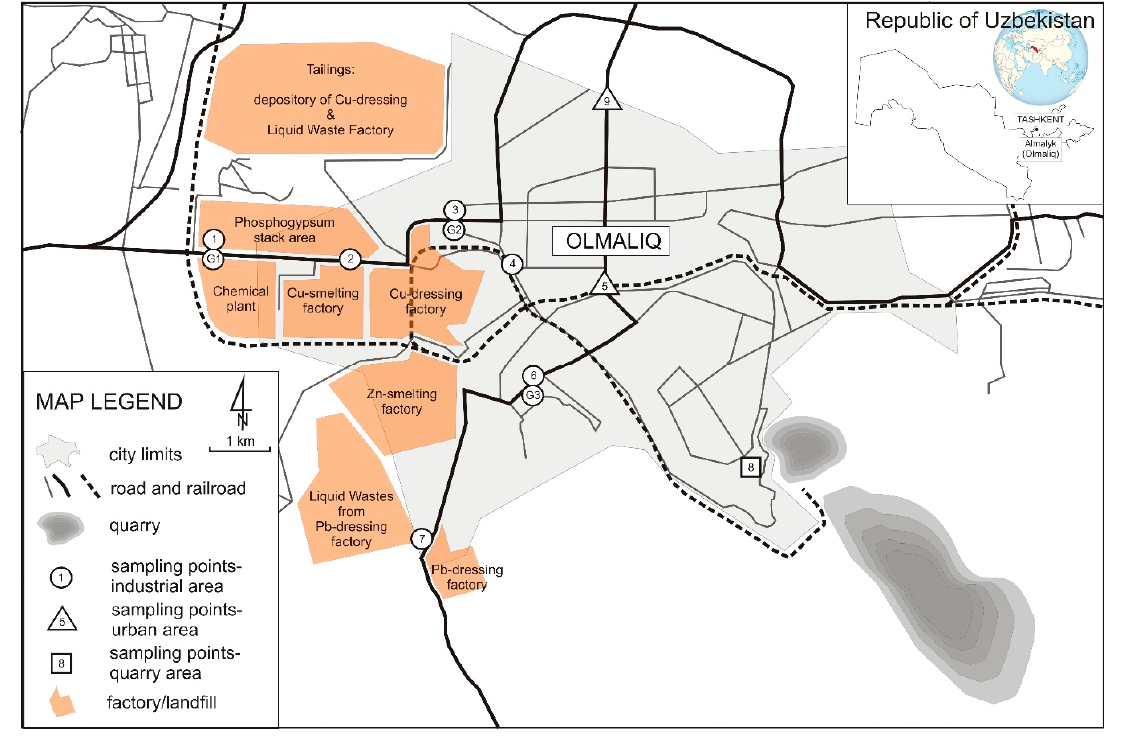
Figure 1. Localization of Populus nigra leaves (No. 1–9) and soil (G1–G3) sampling points in Olmaliq (Uzbekistan).